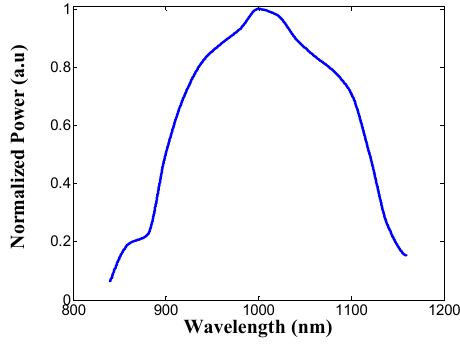
Figure 6. Normalized power in the central core at z = 2.6 mm as a function of wavelength.